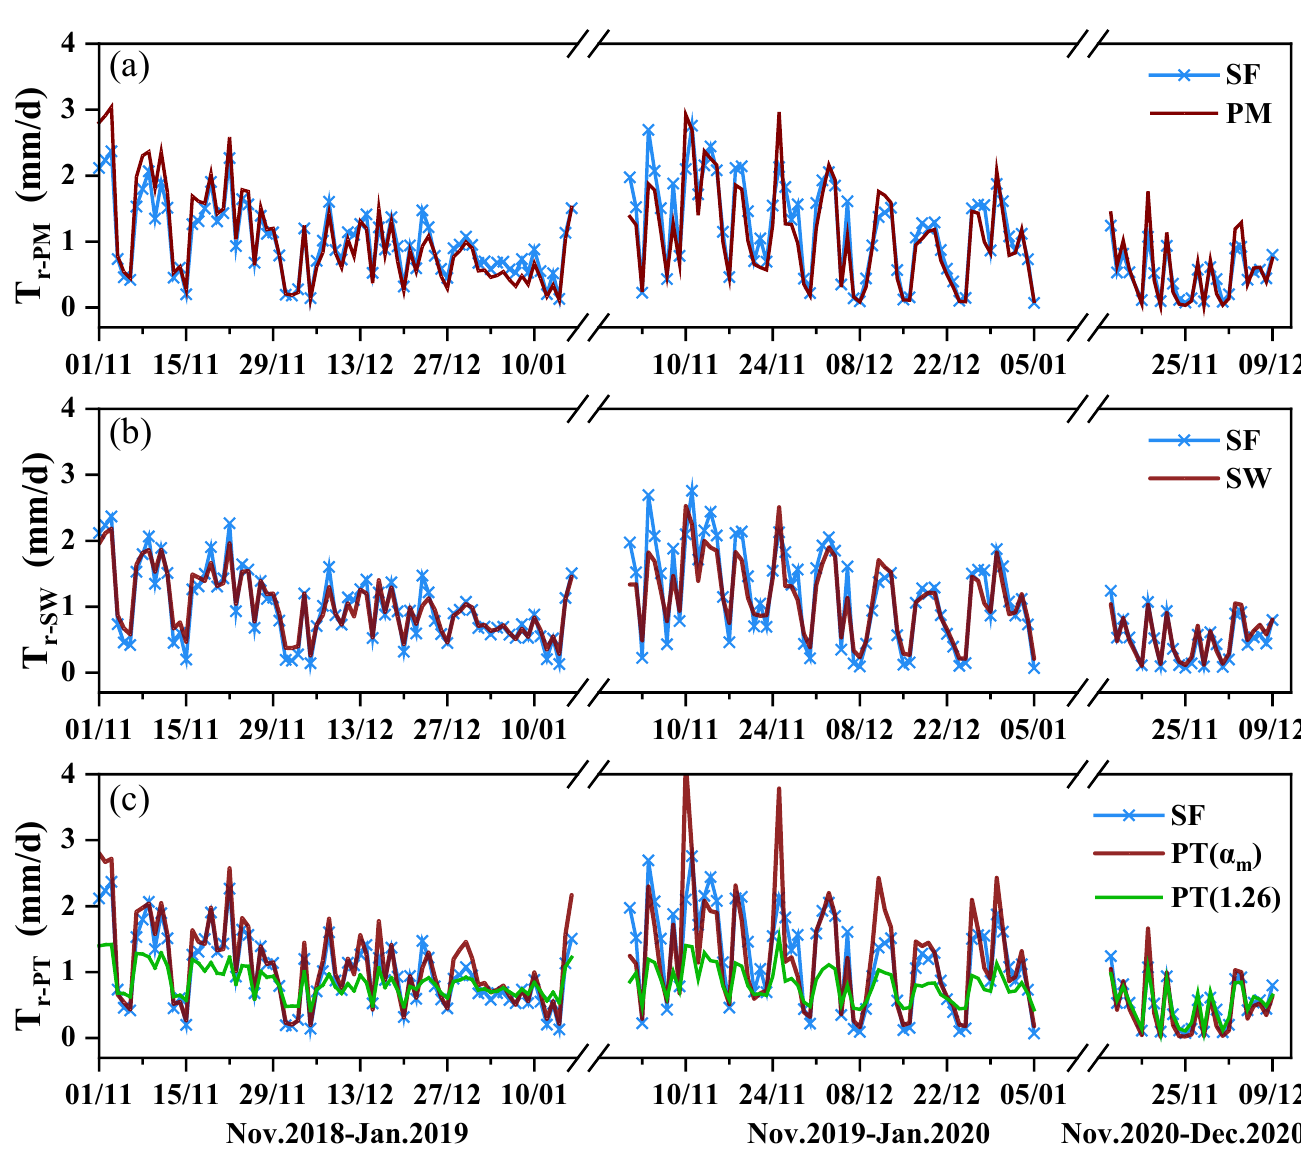
Figure 3. Comparison of the simulated daily crop transpiration by PM (T r-PM , a ), SW (T r-SW , b ), and PT (T r-PT , c ) Methods and measured sap flow (SF) during the three winter seasons. In ( c ), lines of PT indicated that the daily Tr was estimated using the original PT model with α of 1.26, and that in PT( α m ) the line was estimated using α regulated by Equation (28).